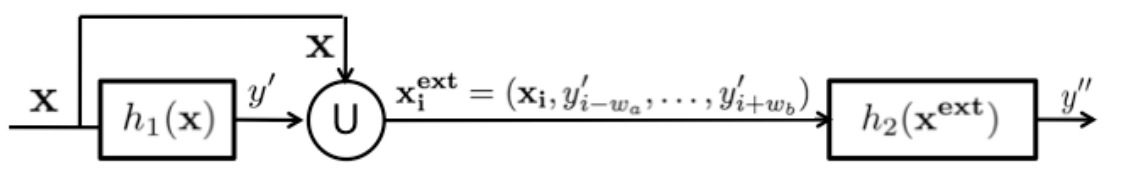
Figure 4. Stacked Sequential Learning